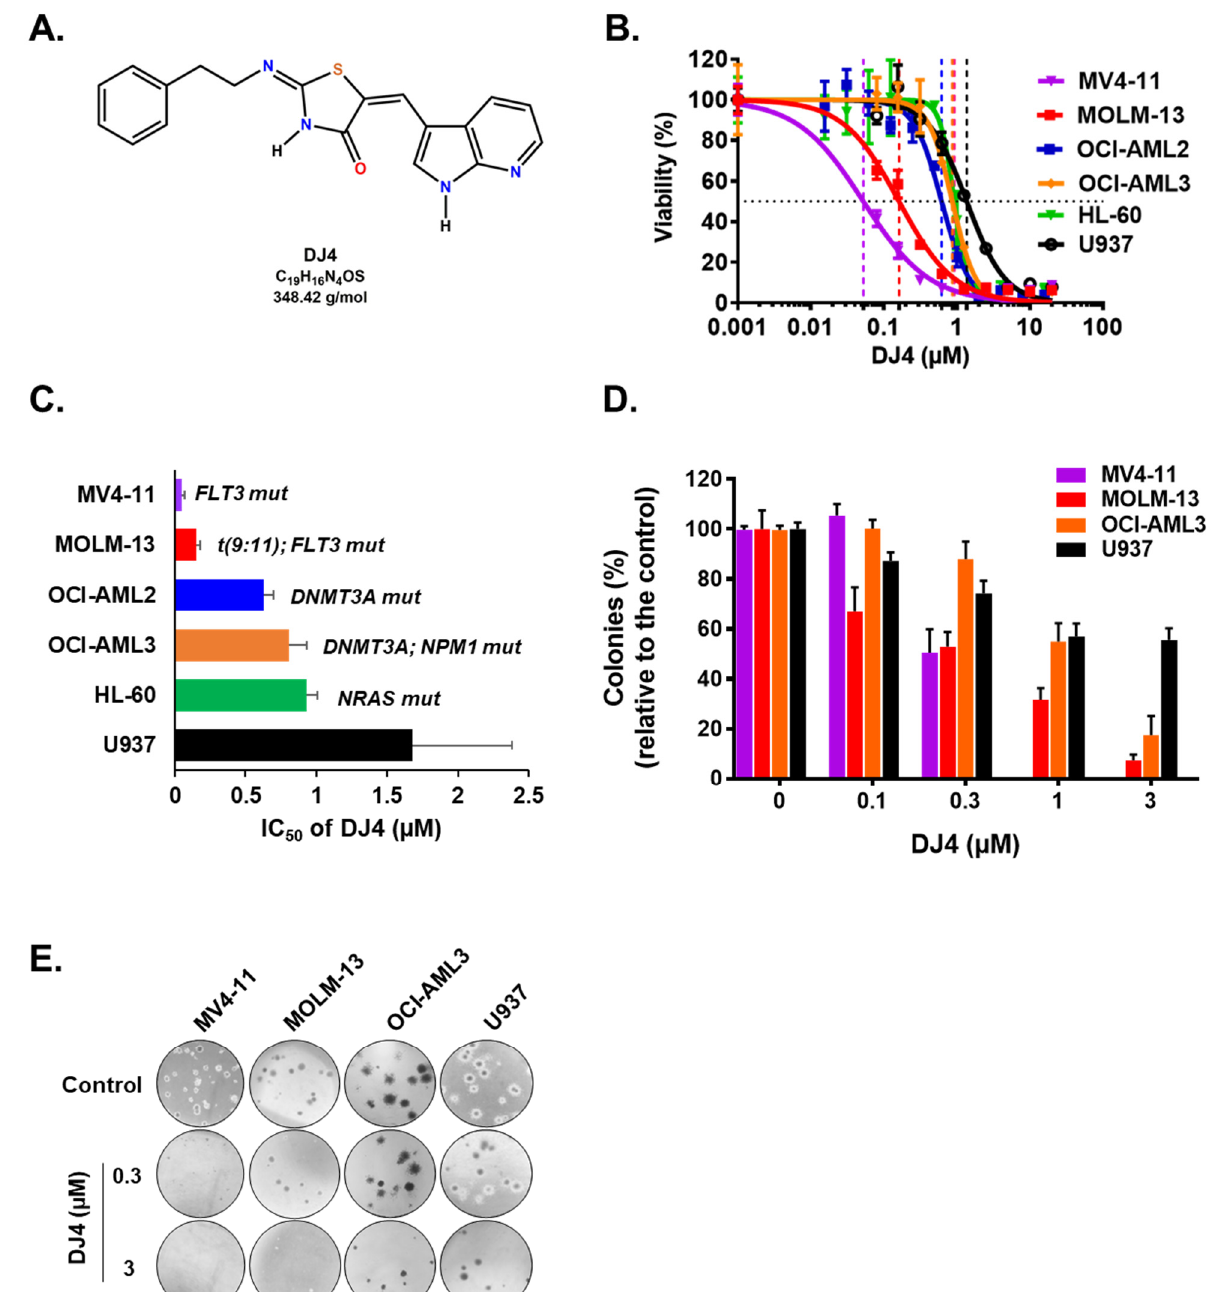
Figure 1. Human AML cell lines are sensitive to DJ4 treatment. ( A ) Chemical structure of DJ4. ( B ) Cytotoxic drug response measured using the MTS assay upon DJ4 treatment for 24 h on various human AML cell lines. ( C ) Corresponding IC 50 ( µ M) values from the MTS assay indicative of the sensitivity of cells with various AML-specific mutations to DJ4. ( D ) Colony-inhibiting capability of DJ4 on AML cell lines. ( E ) Microscopic images (4×) of the DJ4-mediated effect on clonogenicity of AML cell lines in a colony growth medium. The data are the means ± standard deviation (SD).